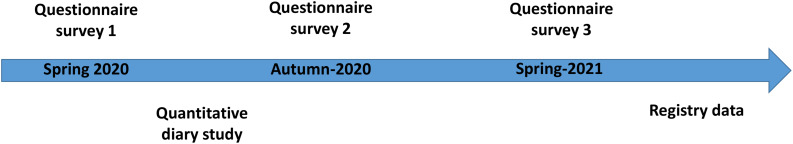
Conceptual model for the research project (direct and indirect associations indicated by blue lines and moderation effects indicated by black lines).